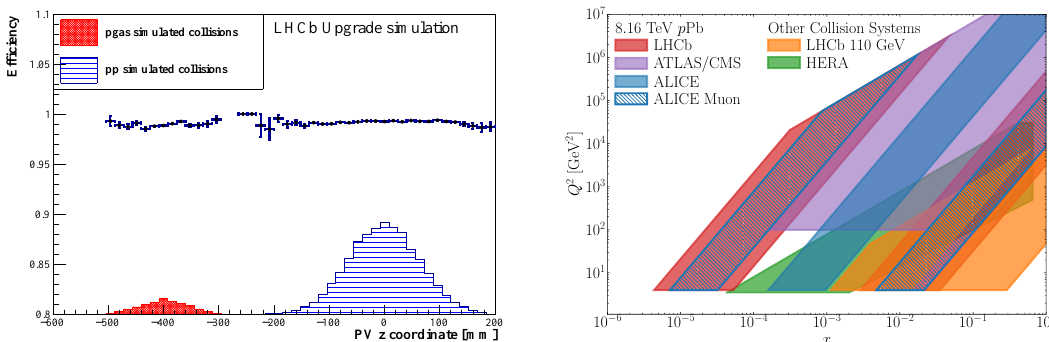
Figure 2: Left: Reconstruction efficiency for beam-gas (red) and beam-beam (blue) primary vertices [ 6 ] . Right: kinematic coverage of LHCspin (orange) and other ex- isting